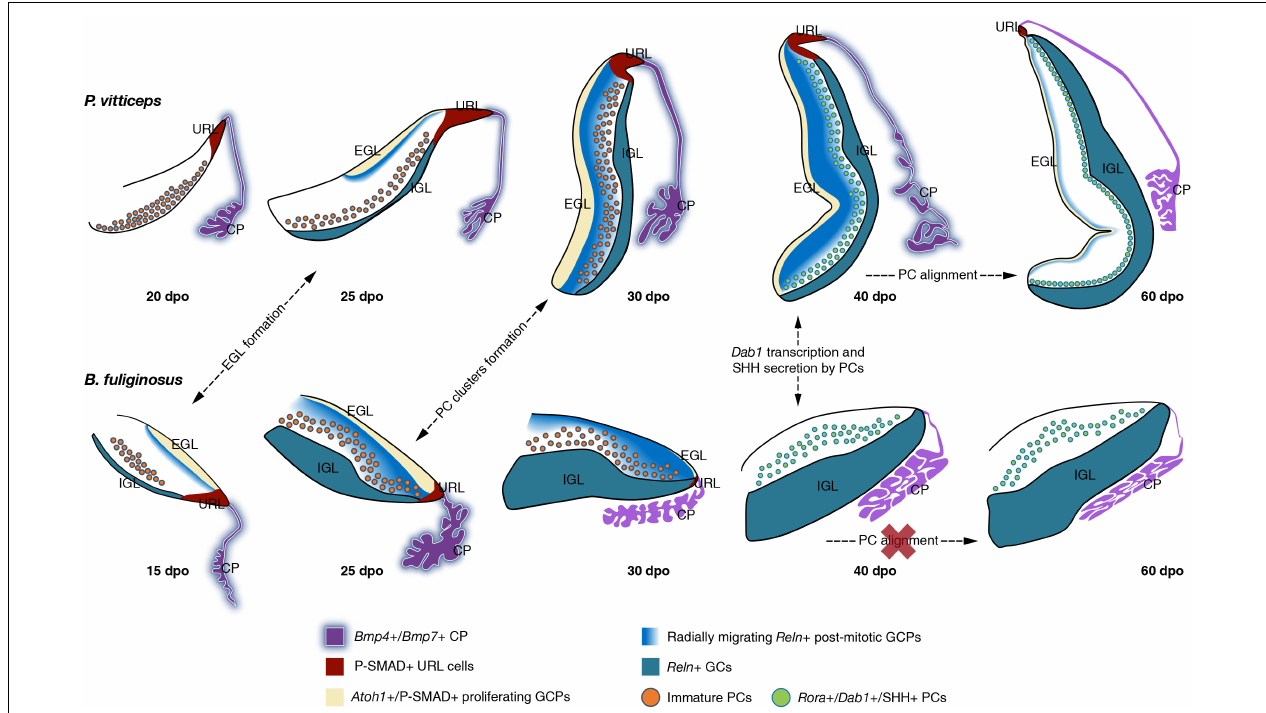
FIGURE 9 | Overview of cerebellar development in squamate models. Schematic representation of the main molecular and cellular events at the origin of the divergent cortical lamination in P. vitticeps (top row) and B. fuliginosus (bottom row) cerebellum. The presence or absence (red cross) of major developmental processes at indicated embryonic stages are shown by dashed arrows. Key gene expression patterns in cerebellar regions and/or cell types identified in this study are indicated by different colors (see color code and symbols in bottom row). EGL, external granule layer; IGL, internal granule layer; URL, upper rhombic lip; CP, choroid plexus; GCP, granule cell progenitor; GC, granule cell; PC, Purkinje